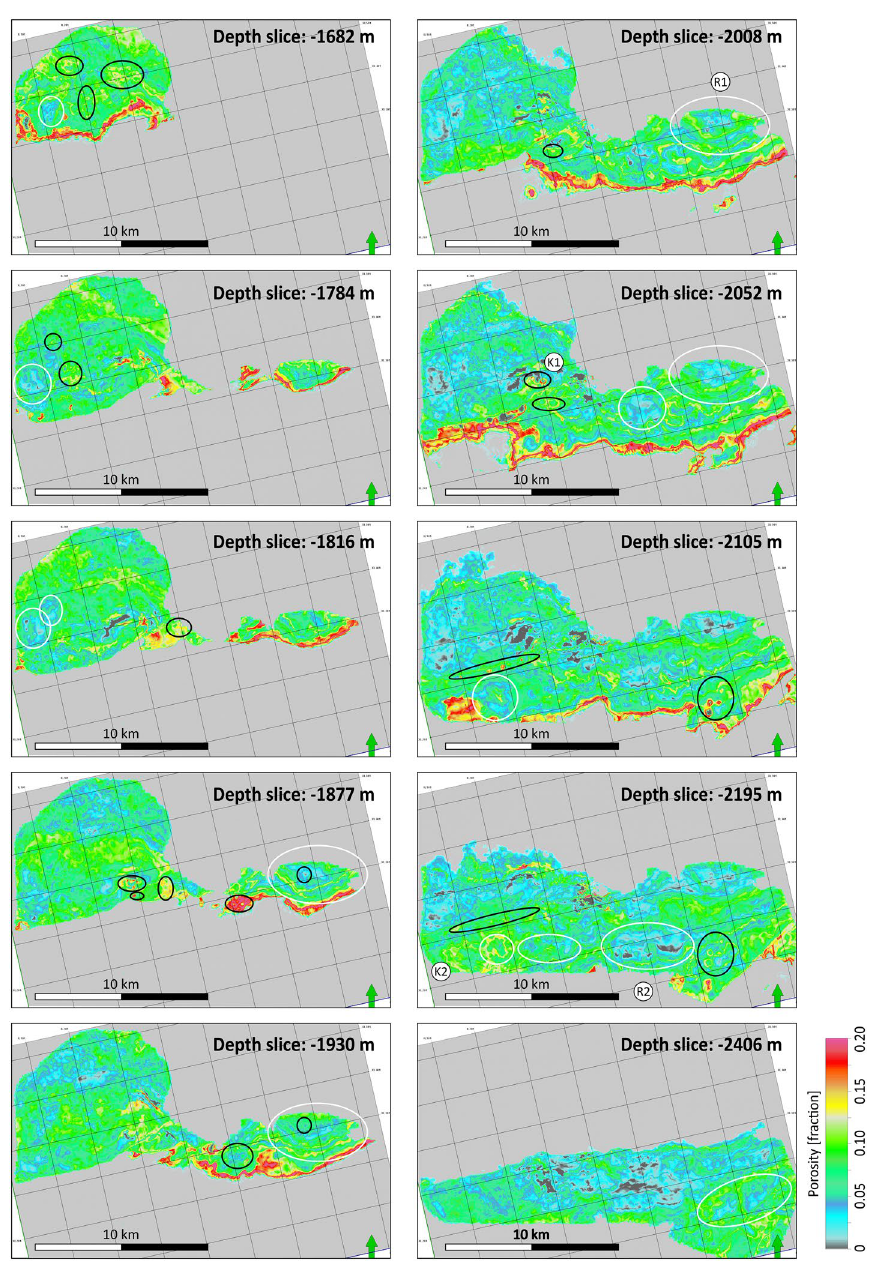
Fig. 11 Depth slices through the porosity model. Only the areas between Top Priabonian and Base reservoir are shown, the other zones such as the Chattian are hidden. Reef buildups are marked by white circles (reefs R1 and R2 are shown in detail in Fig. 12a, b) and karst features by black circles (karst features K1 and K2 are shown in detail in Fig. 12c, d). See text for interpretation